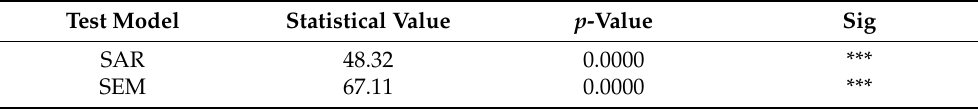
Table 5. Results of spatial econometric model estimation. Test Model